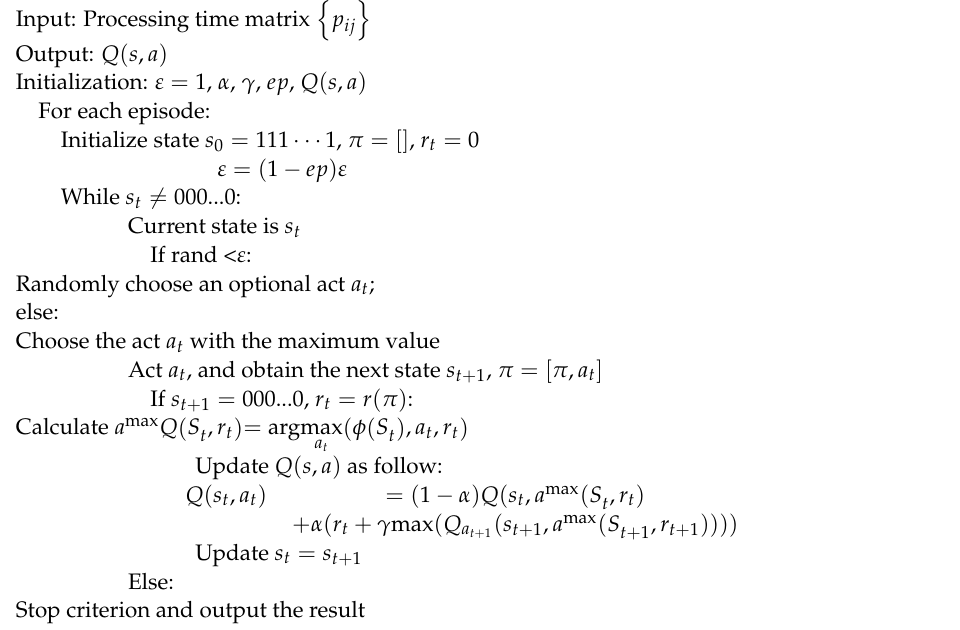
Algorithm 1 Automatic verification scheduling algorithm of electric energy meters based on improved